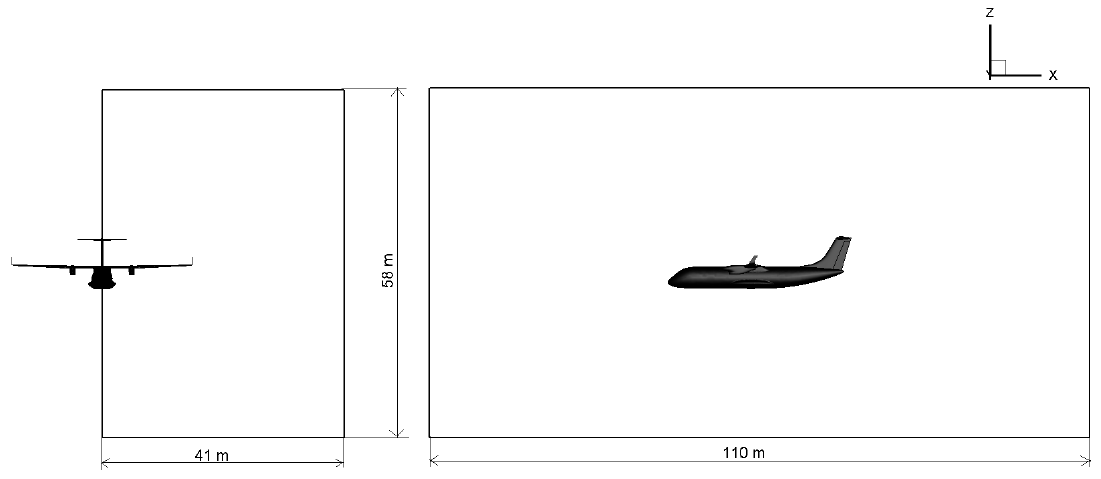
Figure 8. Computational domain: frontal and side views of half the